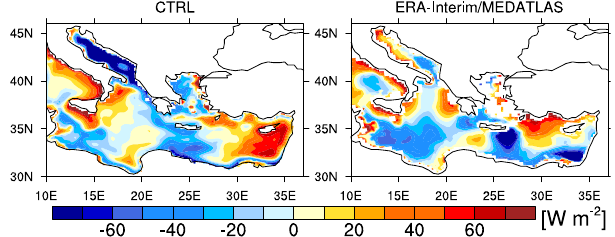
Fig. 16. Difference between the net atmospheric heat input and changes in ocean heat content from 1 May until 30 September. Left panel shows CTRL. Right panel shows differences between net at- mospheric heat input from ERA-Interim Reanalysis (averaged over 1989/2005) and changes in ocean heat content from MEDATLAS climatology. Positive values indicate that the atmospheric input is higher than the temperature change in the water column, reflecting an export of heat from this region. Negative values reflect a heat